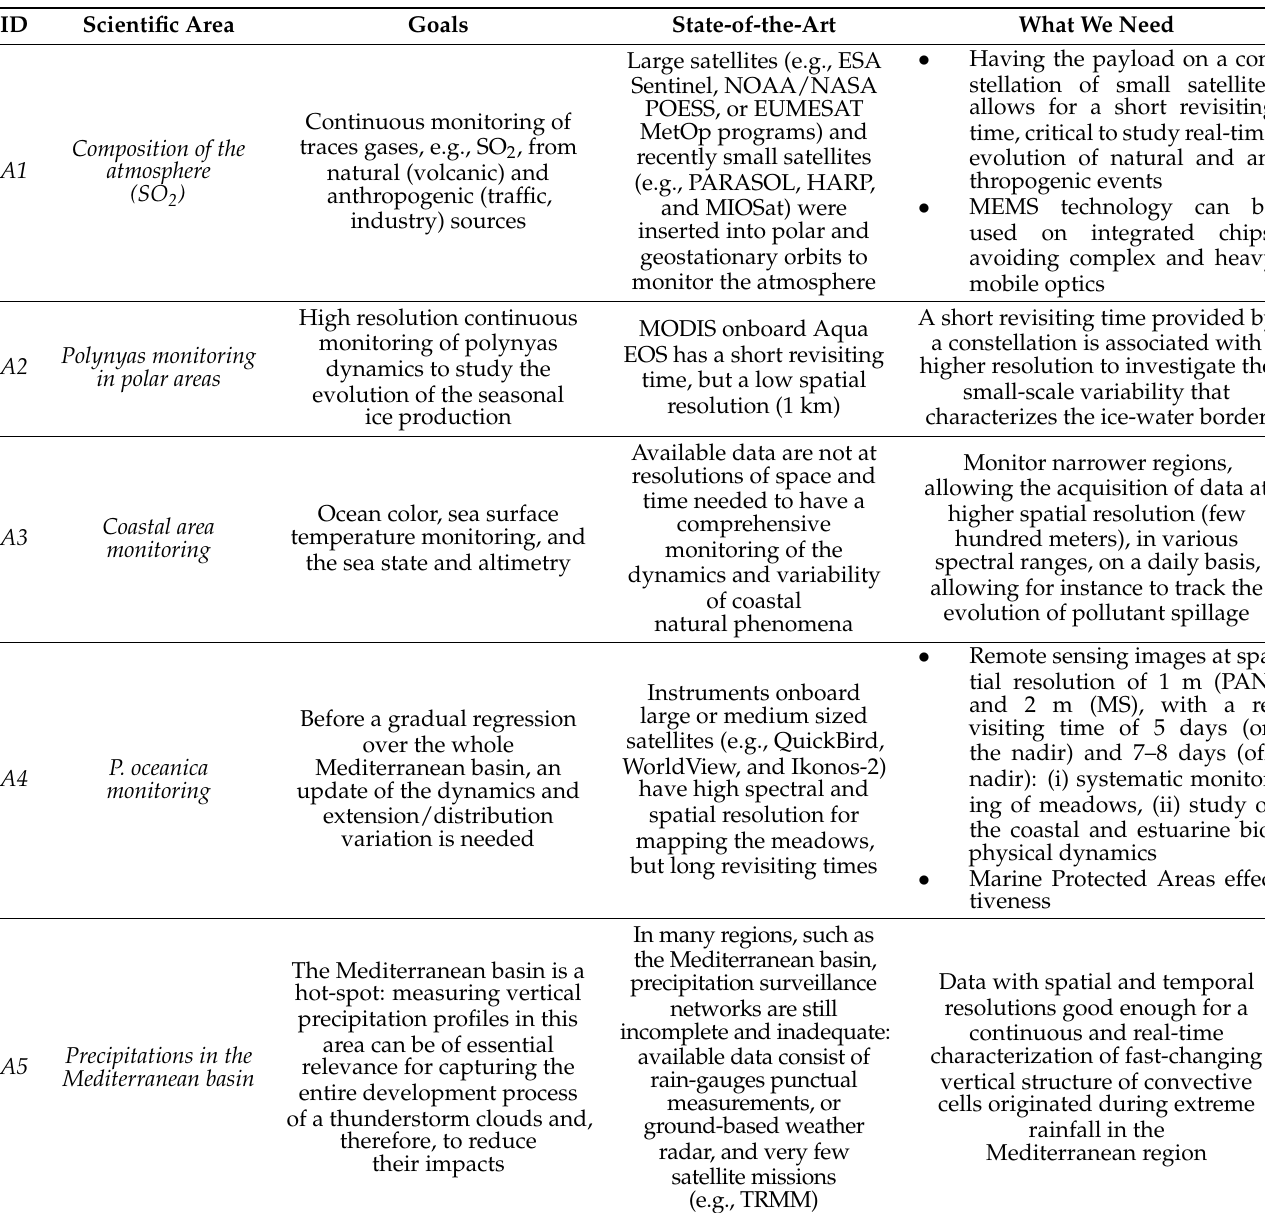
Table 3. Summary of the study cases presented in Section 3. The forth column reports the current available data to study the specific research case, whereas the last one shows what it is still missing for a complete understanding of the related